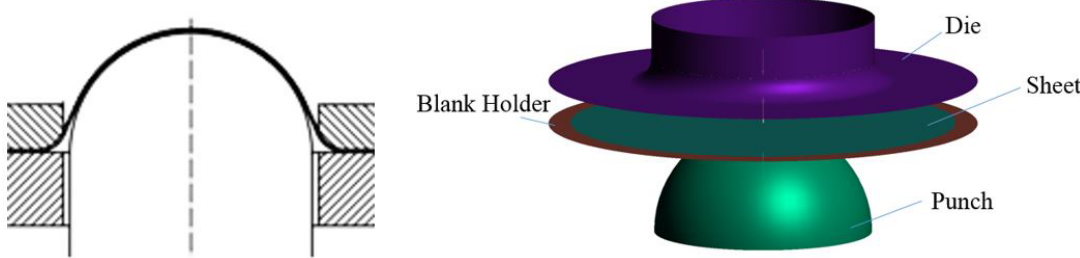
Figure 2. Schematic view of nakajima Forming Die Table 2. Mechanical properties of DP600, DP800 and DP1000 steels 13